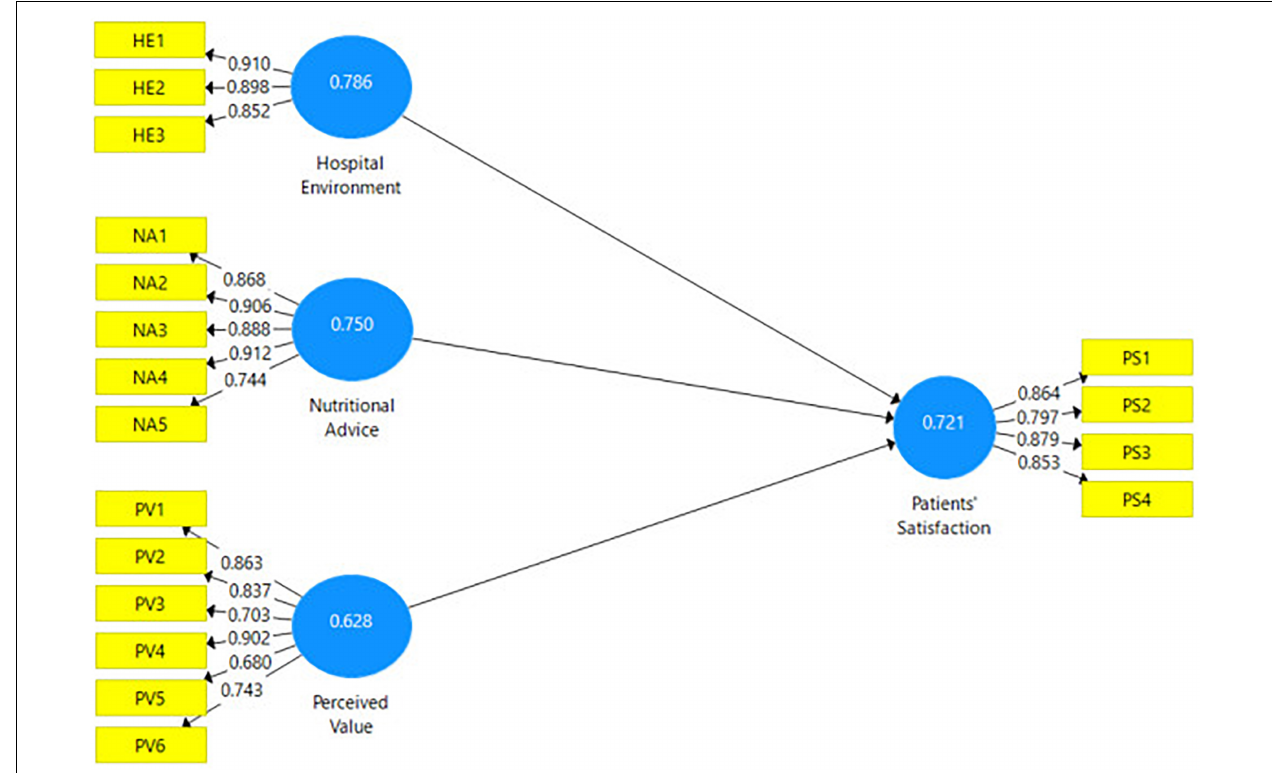
FIGURE 2 | Measurement model.